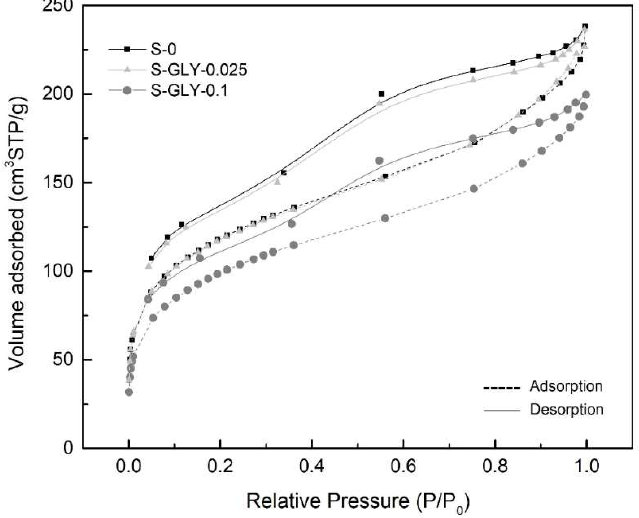
Figure 6. Nitrogen gas adsorption/desorption isotherms for aerogel-like materials with and without GLY additive.